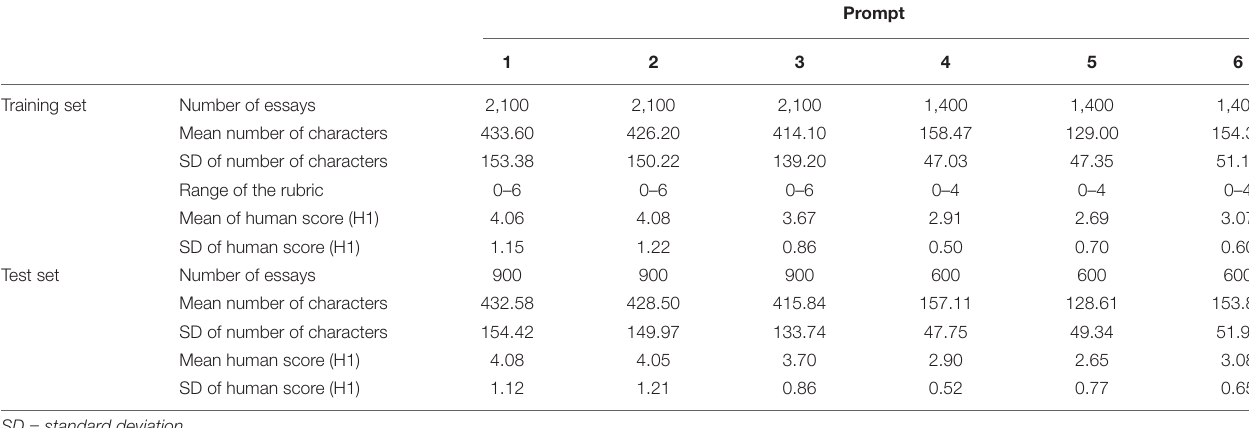
TABLE 2 | Description of the training and test sets.